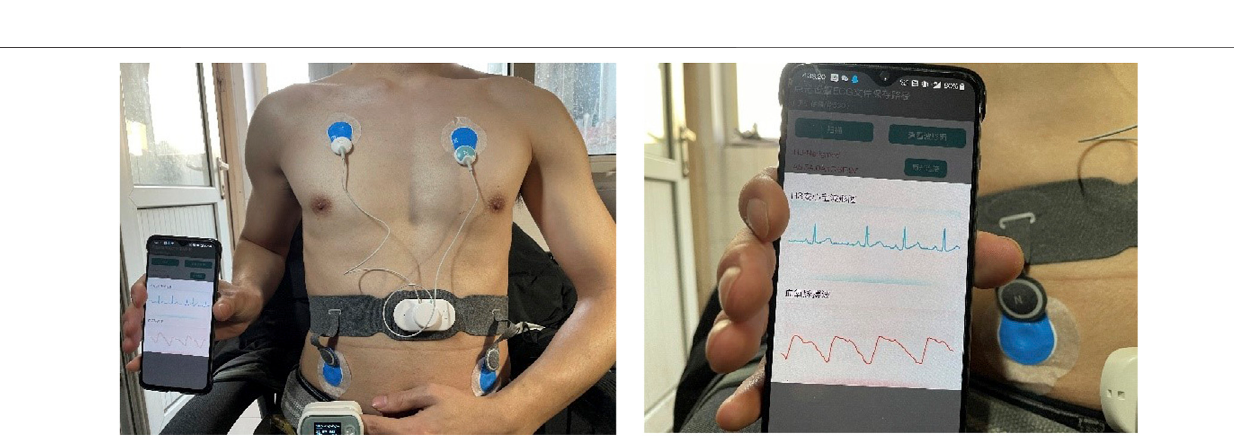
FIGURE4|(A) Time-domainplotsofthescalefunctionandMorletwaveletfunction; (B) Littlewood – Paleysums; (C) 41 fi rst-orderwaveletfunctions; (D) 7second- order wavelet functions.